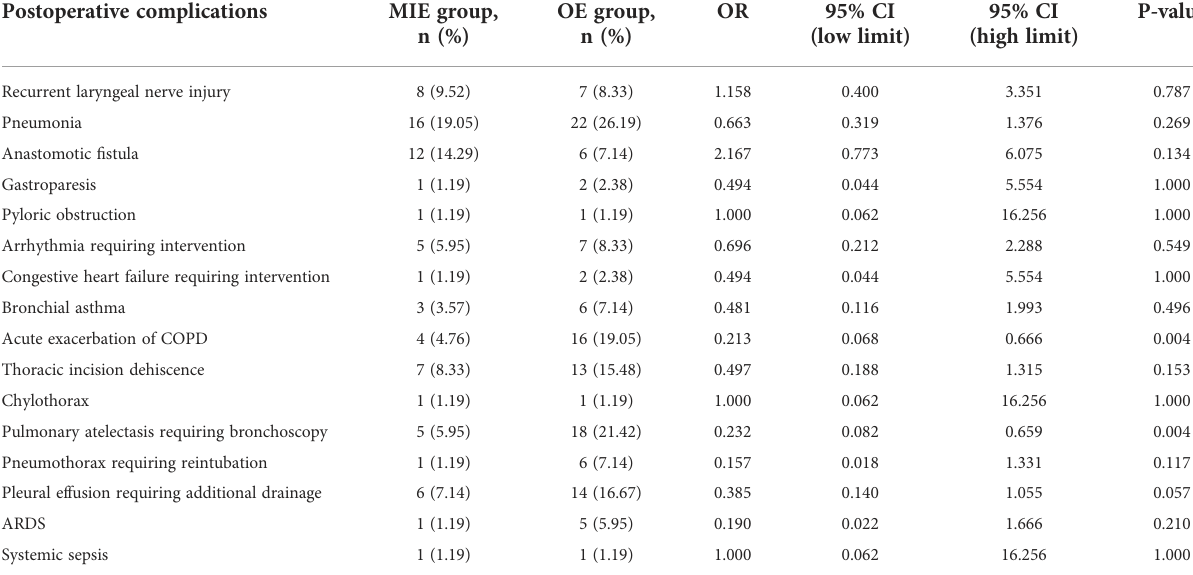
TABLE 3 Postoperative complications in the minimally invasive esophagectomy (MIE) and open esophagectomy (OE) groups. Postoperative complications